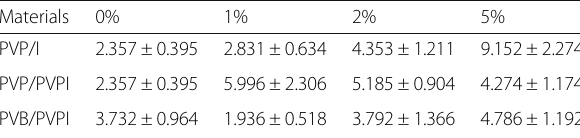
Table 3 Average pore sizes of the electrospun fibrous mats, with unit of micrometer